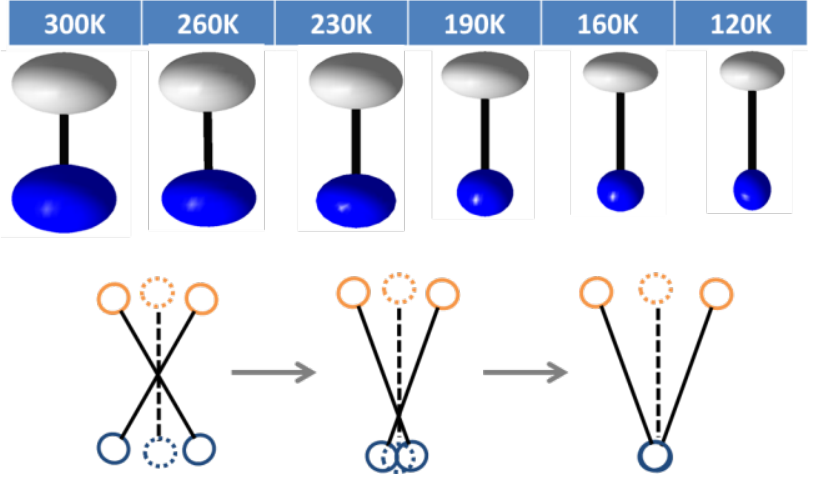
Figure 4. C-N thermal ellipsoids (at 50% probability) and the possible vibration modes of MA at different temperatures. Grey and brown: C, blue: N.